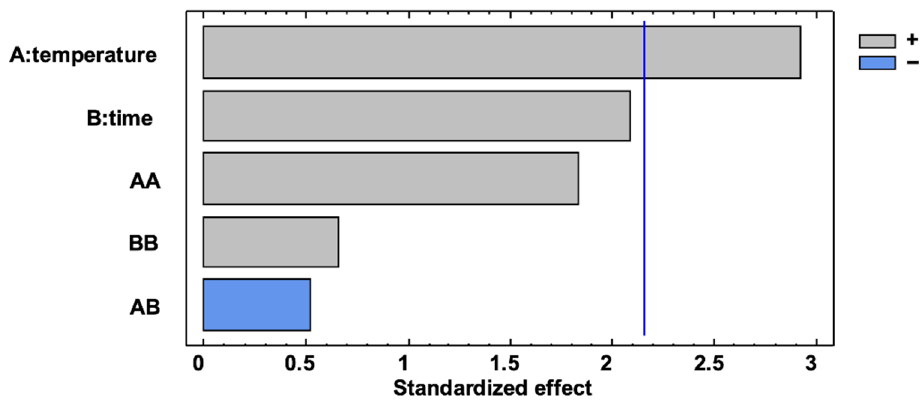
Figure 1. Pareto chart of the optimization of the microwave extractions (TPI).